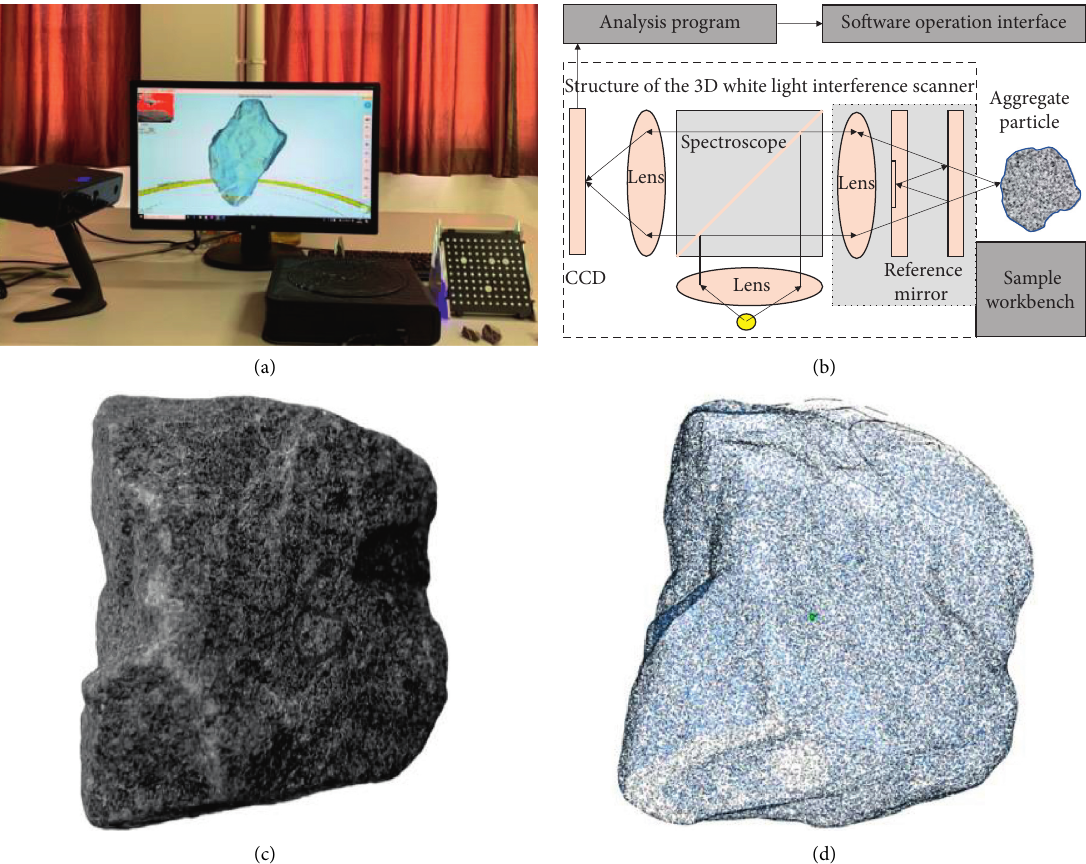
Figure 2: Point cloud data acquisition instrument and 3D scanning principle. (a) EinScan-S 3D scanner. (b) Principle of 3D scanning technology. (c) Coarse aggregate particle. (d) 3D coordinate lattice